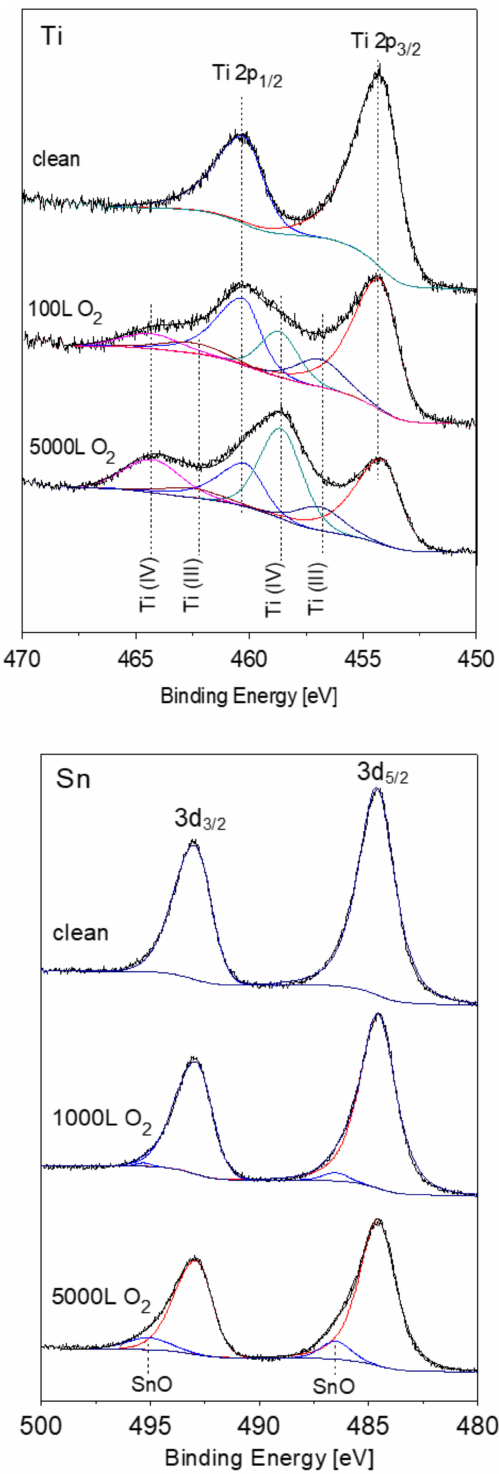
Figure 4. Representative XPS Ti 2p and Sn 3d spectra with the fitted metallic and oxide